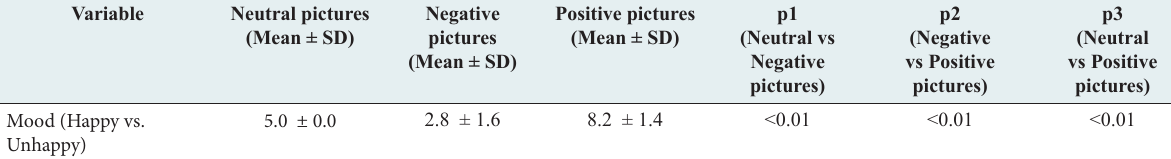
Table 2: Comparison of ratings of self-assessment scale for positive, neutral and negative mood